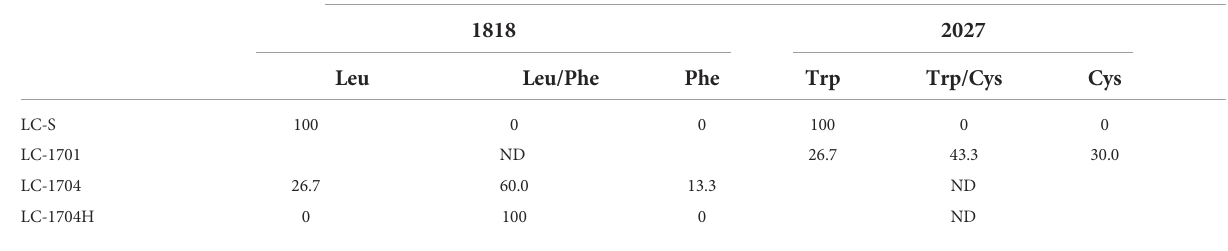
TABLE 4 Distribution of polymorphism at each ACCase mutation site in different Leptochloa chinensis individuals.